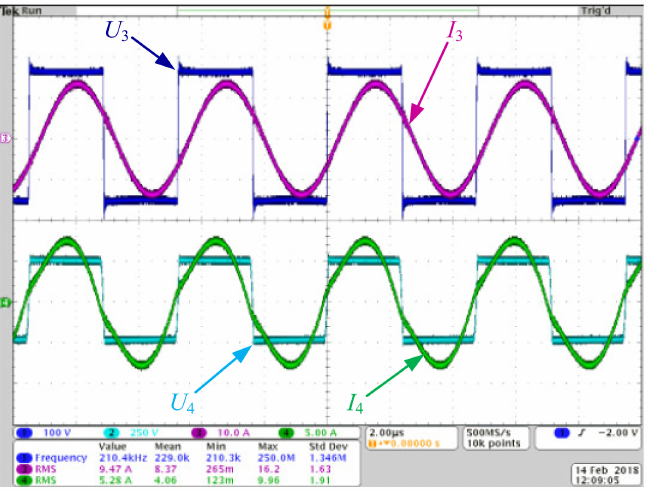
Figure 10. The voltage and current waveforms of the system.